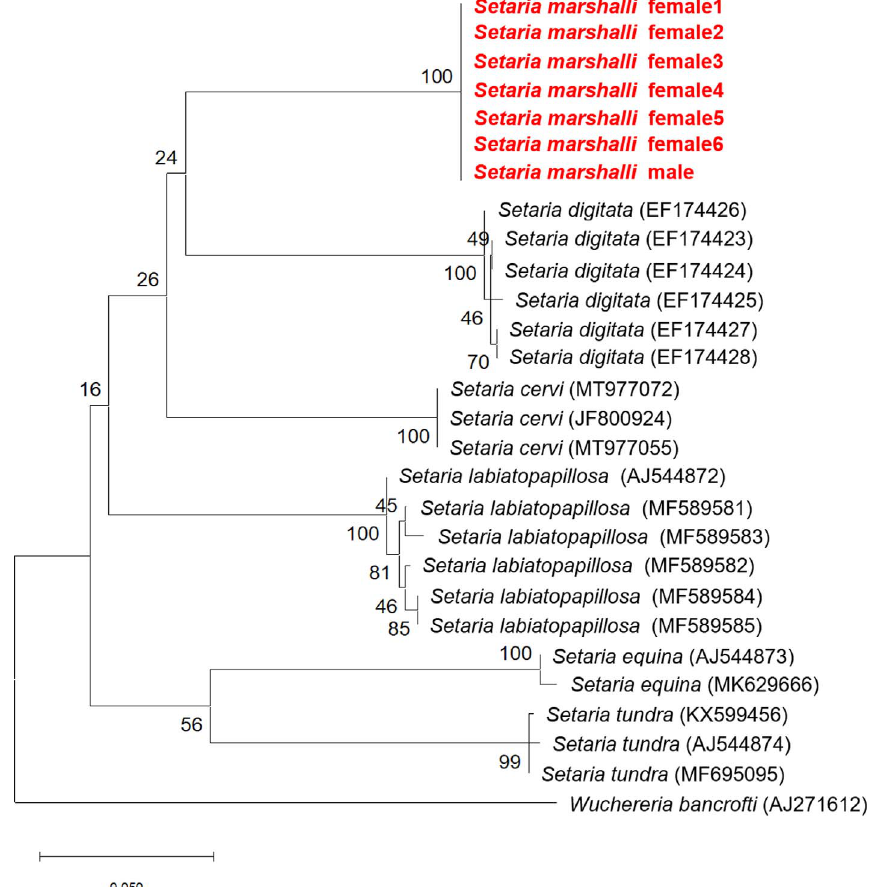
Figure 4. Maximum likelihood (ML) phylogenetic tree based on nucleotide sequences of mitochondrial DNA of the cytochrome oxidase subunit I ( COI ) region. Setaria marshalli is shown in bold red. All sequences of the species obtained in this study were identical and deposited at the INSD under accession No.